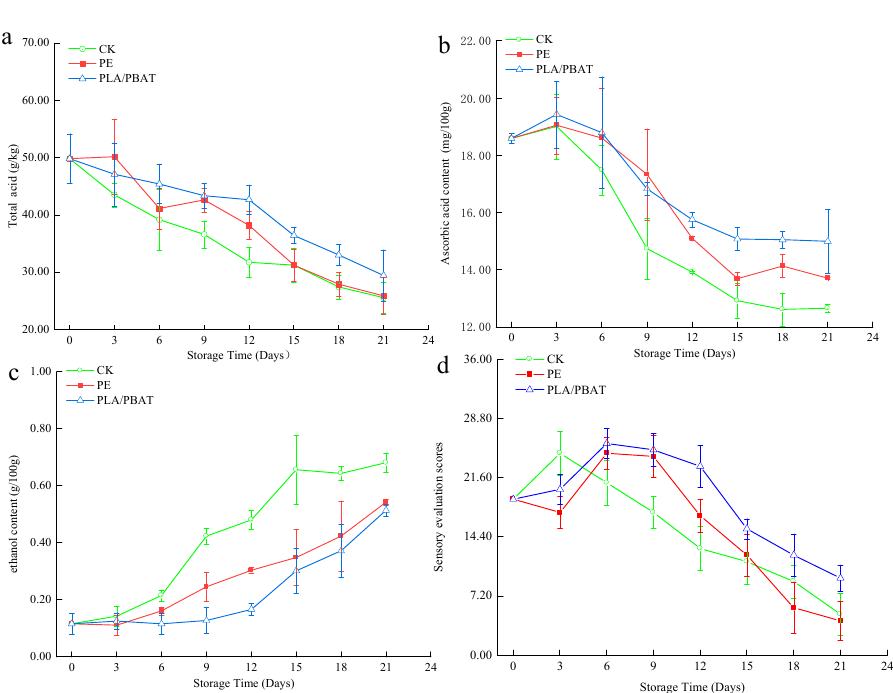
Figure 2. E ff ect of PLA / PBAT antibacterial packaging film on the ( a ) total acid, ( b ) ascorbic acid, ( c ) ethanol content, and ( d ) sensory evaluation of passion fruit during storage times (t =